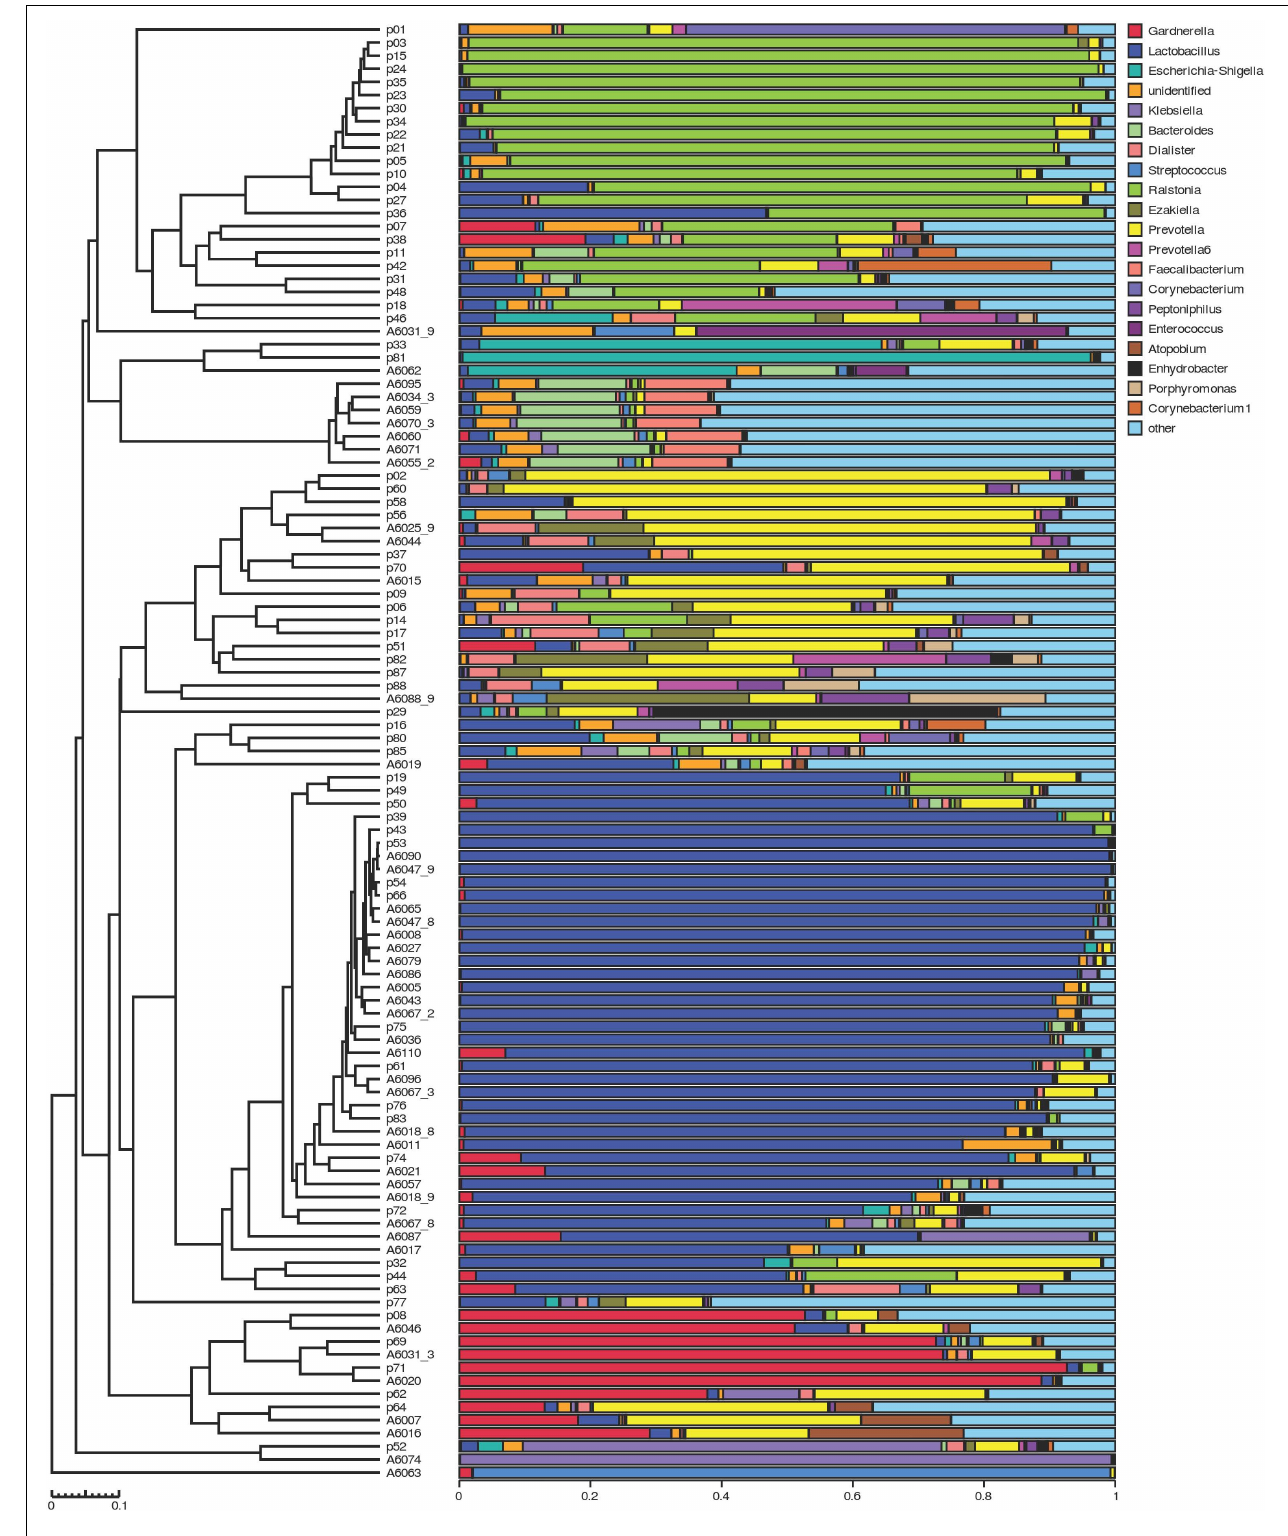
FIGURE 2 | The clustering histogram of individual sample at the genus level. Hierarchical clustering analysis between samples is shown on the left. Histogram of individual sample’s community structure is shown on the right. X-axis was the relative abundance of bacteria, and Y-axis was the sample name (p stood for patients with RUTI, A stood for